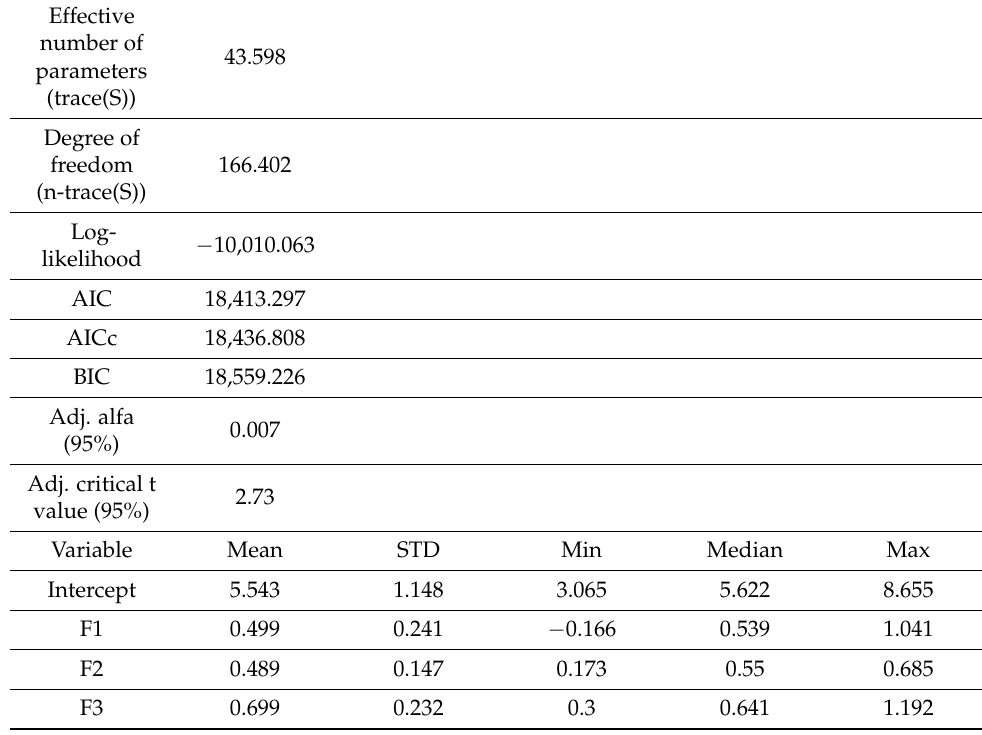
Table 3. GWR diagnostic information and summary statistics for GWR parameter